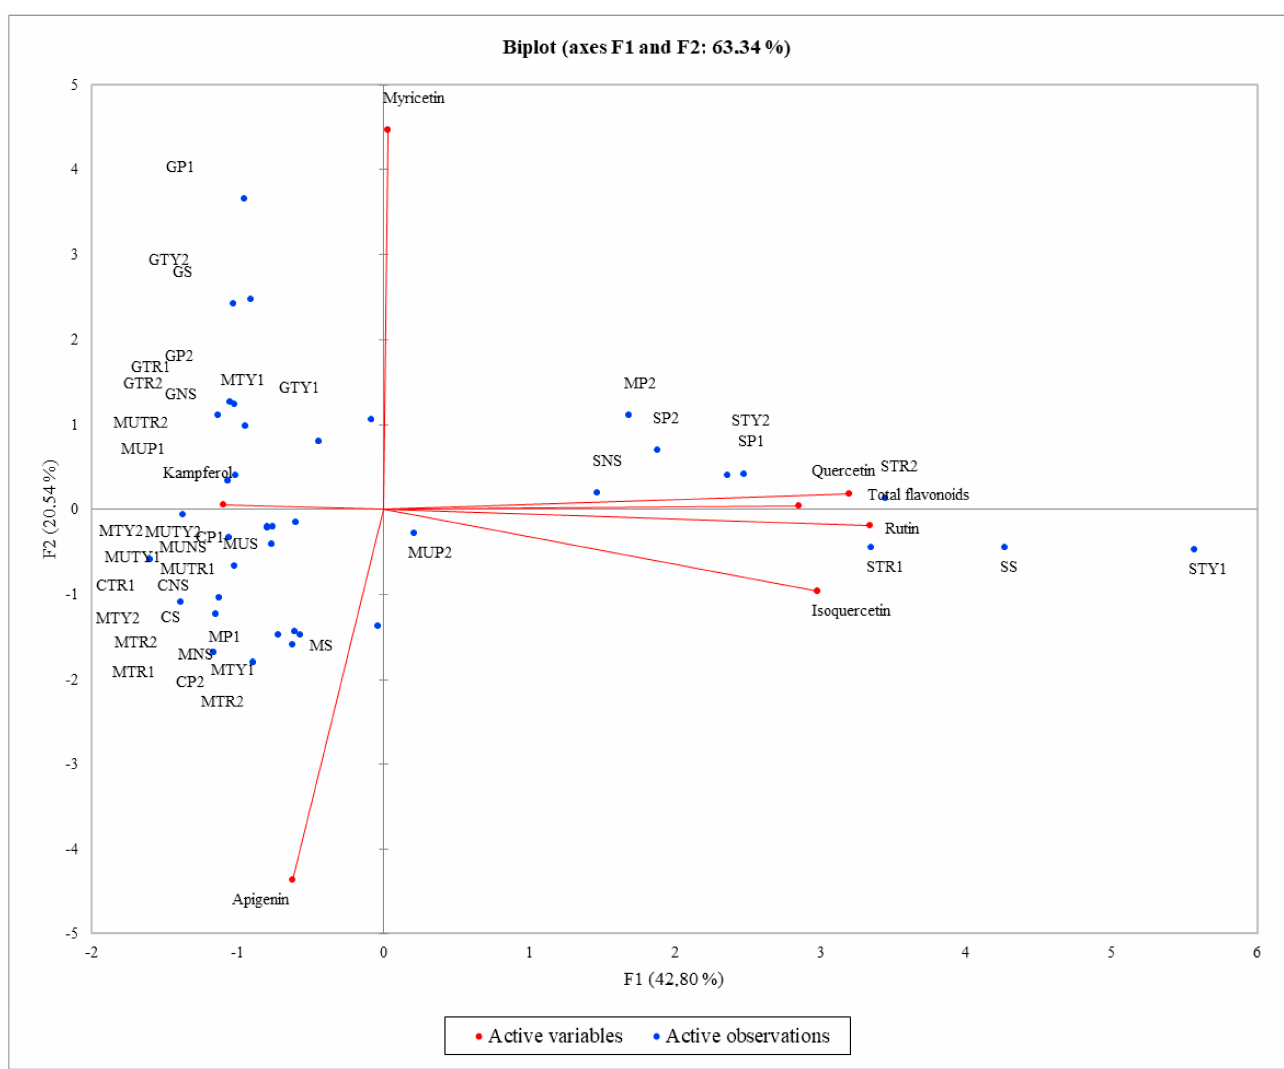
Figure 3. Principal component analysis (PCA) for total amount of flavonoid their chemical composition in different varieties of mint sprayed with different amino acids.